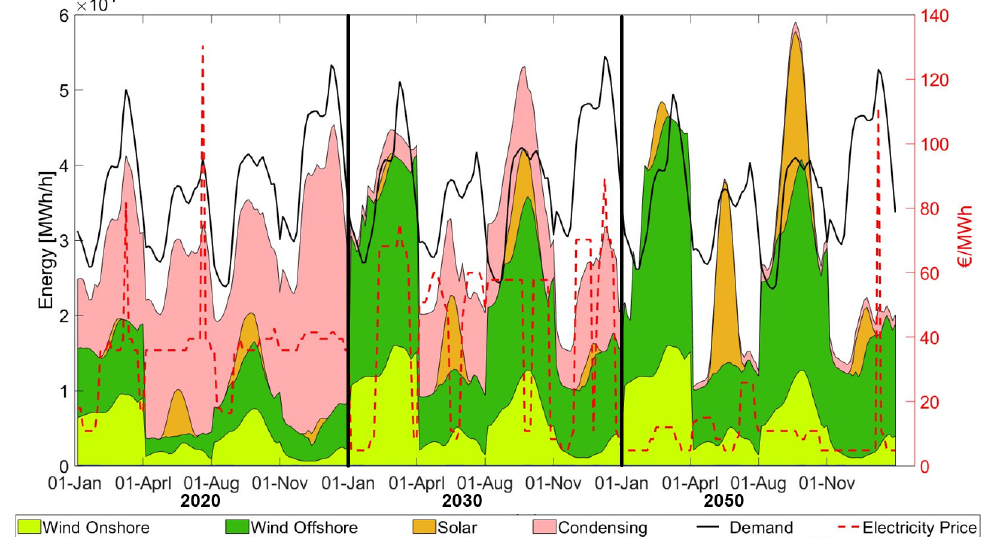
Figure 7. Hourly dispatch and electricity prices for four representative days of each year in Great Britain using UC-MIP. The demand profile corresponds to the exogenous profile. Endogenous demand from electricity storage or use of electricity-to-heat units in GB is negligible in the stud- ied